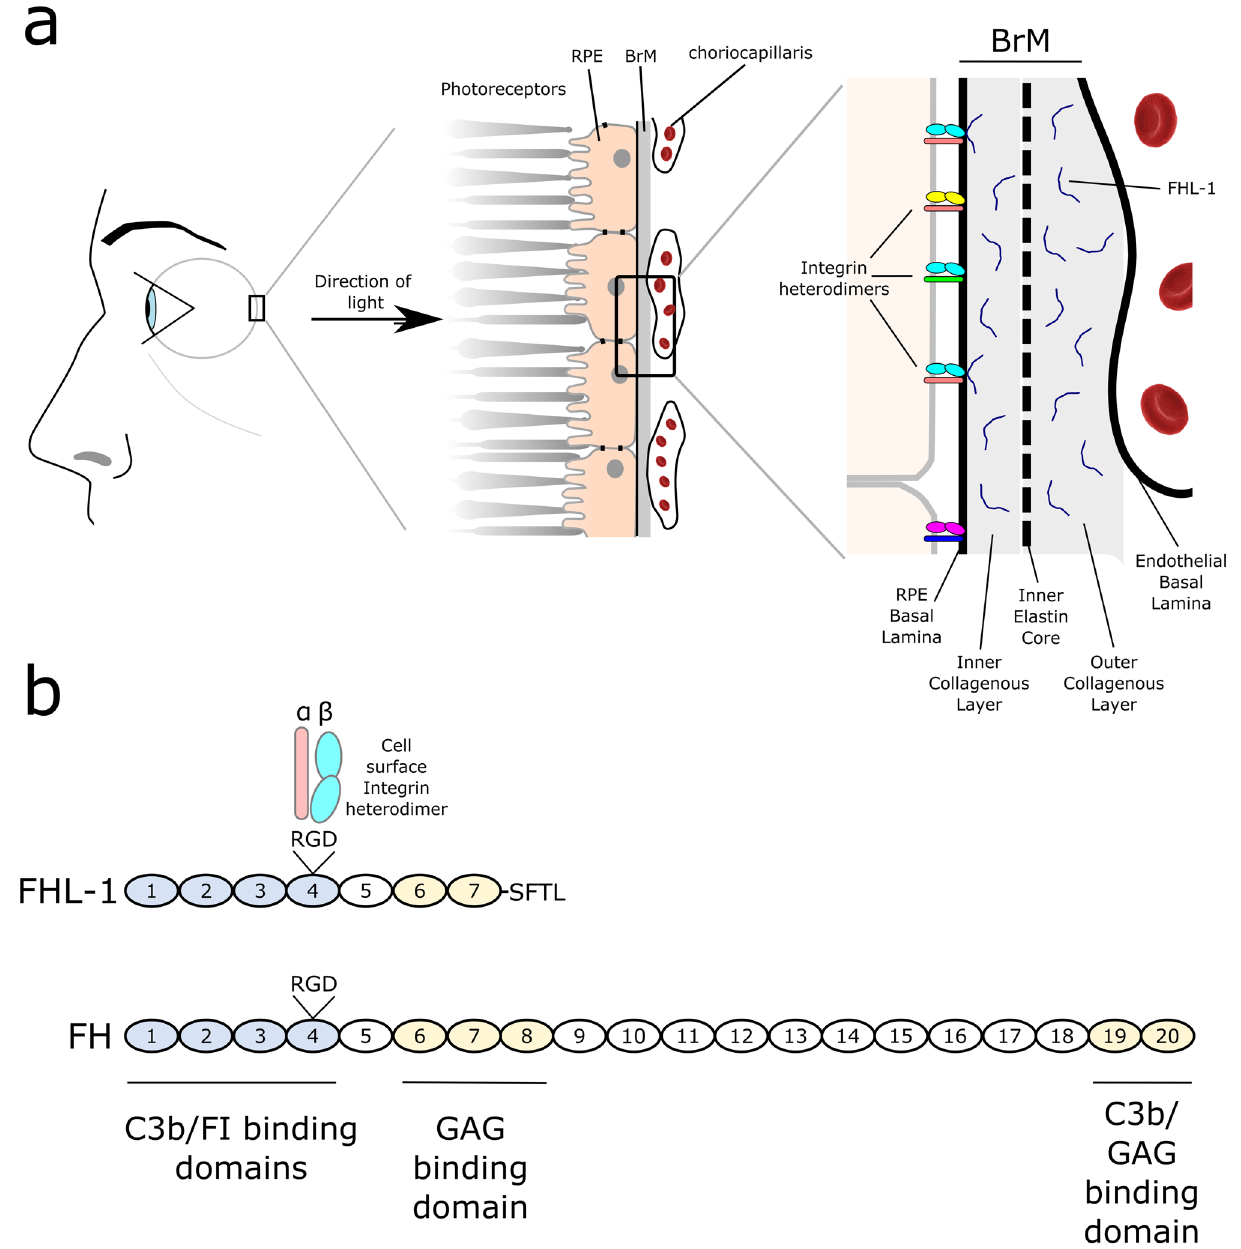
Figure 1. Schematic of RPE cell interactions with their underlying ECM. ( a ) The RPE forms a monolayer on Bruch’s membrane and plays a crucial role in maintaining photoreceptors. Bruch’s membrane separates the RPE from its blood supply, the choriocapillaris. RPE cells adhere to, and interact with, ligands within the basement membrane of Bruch’s membrane (BrM), including FN and LA, through various integrin heterodimer receptors expressed on their surface. Bruch’s membrane comprises five separate layers: the RPE basement membrane; the inner collagenous layer; an elastin core; the outer collagenous layer; and the endothelial basement membrane layer. The complement regulator FHL-1 is found anchored to heparan sulphate and dermatan sulphate glycosaminoglycan (GAG) chains found in collagenous and basement membrane layers of Bruch’s membrane. ( b ) Both FH and its truncated variant FHL-1 are comprised of complement control protein (CCP) domains: FH has twenty domains, while FHL-1 has seven CCPs identical to FH but with a unique C-terminal tail. Both proteins also share an RGD integrin-binding motif in